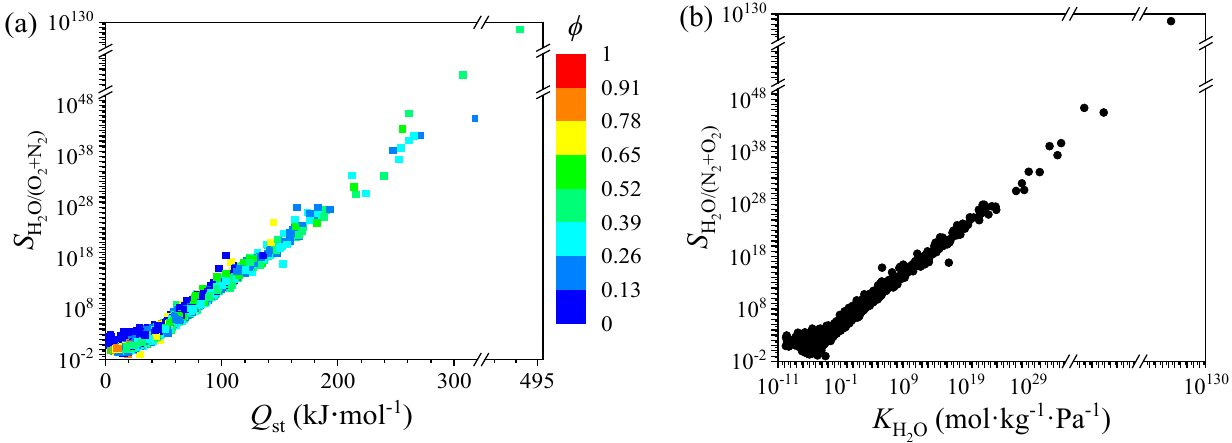
versus ( a ) Q st , ( b ) K H2O . The color code 2 O/(N 2 +O 2 )]